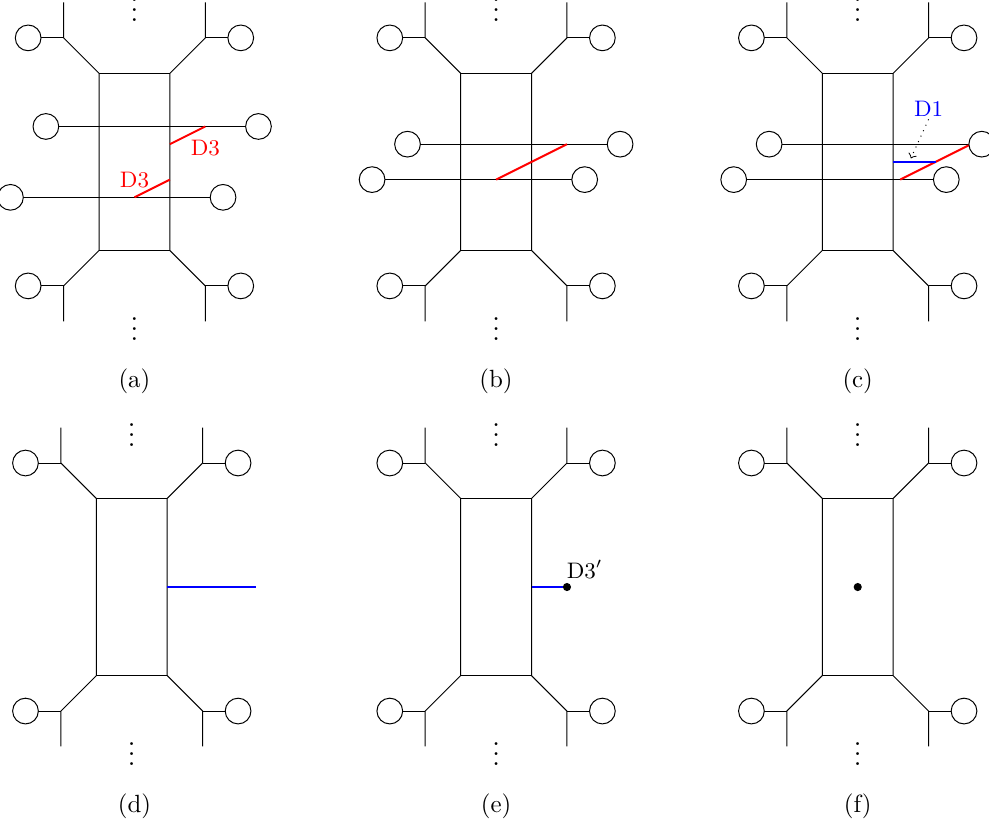
Figure 9. The realization of a codimension 4 defect via Higgsing. The starting point is the 5-brane web for SO(2 N + 2) , see figure 4. However, only the central part is relevant for the discussion such that the orientifolds are omitted here. In (a), two codimension 2 defects are realized via defect Higgsings. In (b), suitably adjusting the defect parameters allows to reconnect the two defect D3-branes as shown. In (c), the resulting D3 can be move along 5-branes, which is on the defect Higgs branch, but the D3 leaves behind an attached D1-brane. In (d), the defect D3 as well as the 5-branes on the Higgs branch have been moved off to infinity, leaving a semi-infinite D1-brane. This realizes a codimension 4 defect. In (e), the semi-infinite D1 is terminated on a D 3 0 -brane, occupying x 0 , 7 , 8 , 9 . In (f), the D 3 0 has been moved inside the brane web, upon which the D1-brane has been annihilated. This connects to the codimension 4 defect of table